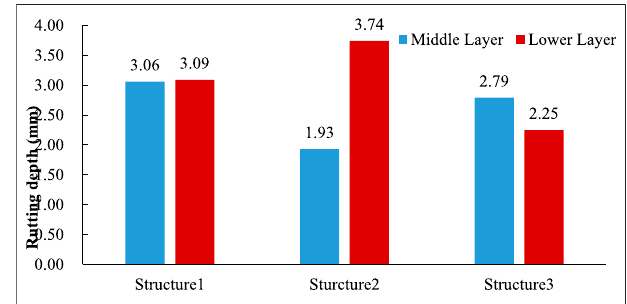
FIGURE 6 | Standard rutting test results of asphalt mixtures for each pavement